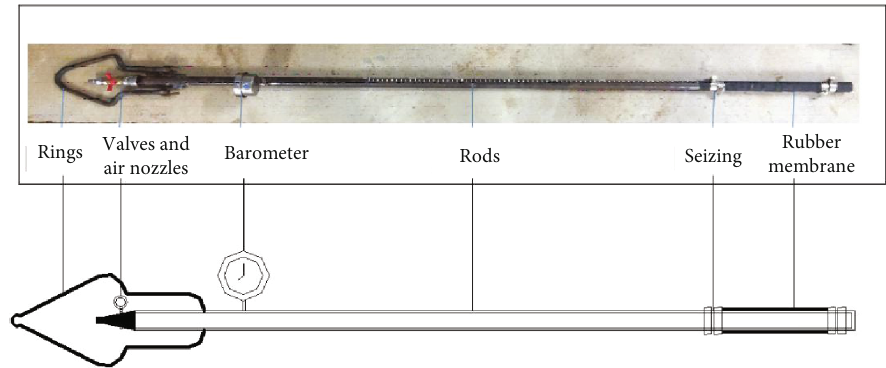
Figure 1: Physical model of in fl atable anchor and its